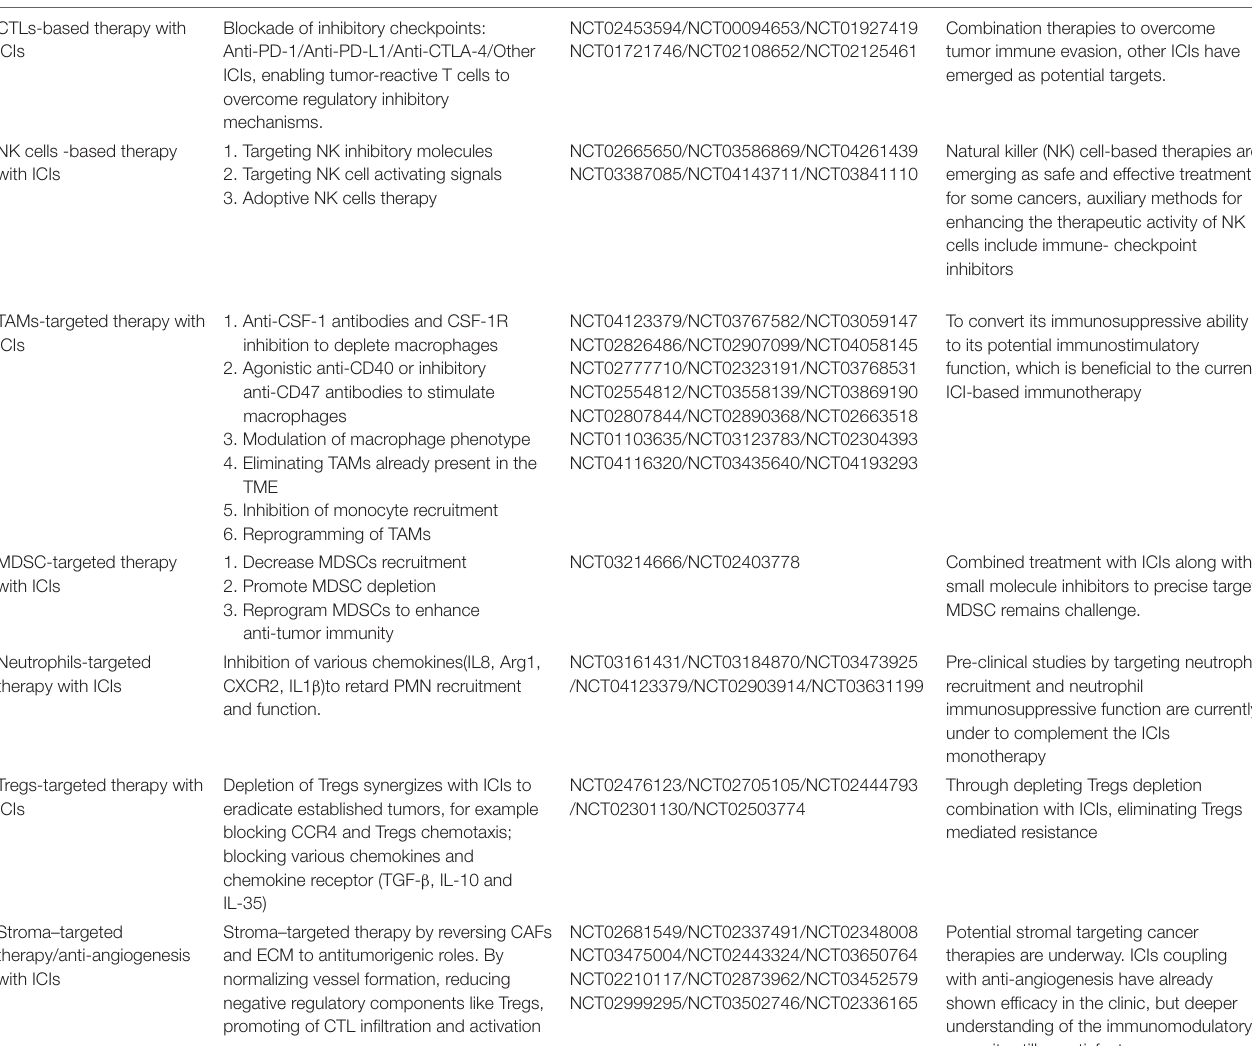
TABLE 1 | Landmark and ongoing trials of targeting tumor immune microenvironment synergize